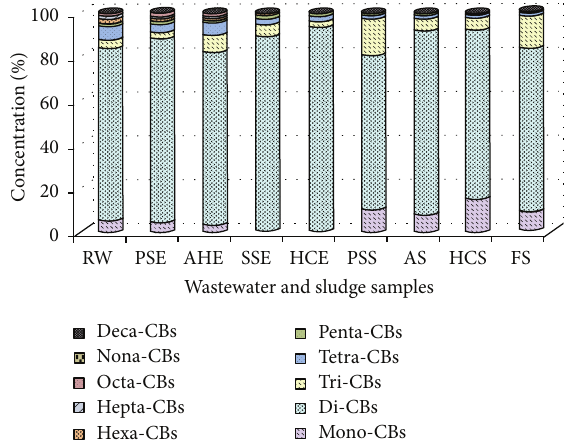
Figure 2: PCB isomer profiles in wastewater and sludge samples of the WWTP.